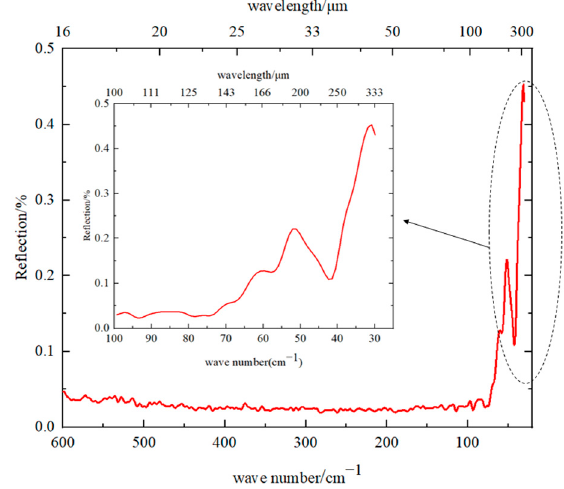
Figure 2. Reflection of ERB-2 paint.